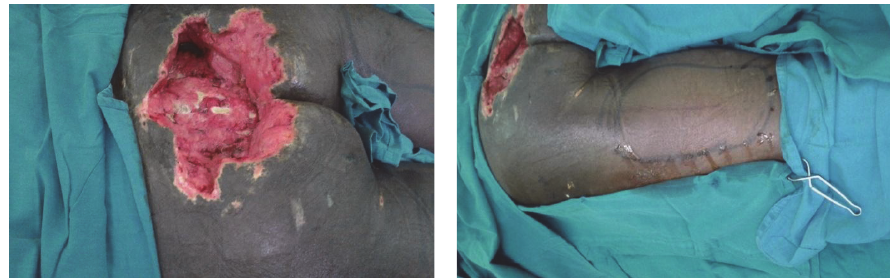
Figure 3: Extensive sacral wounds in the second patient with markings for the flap.